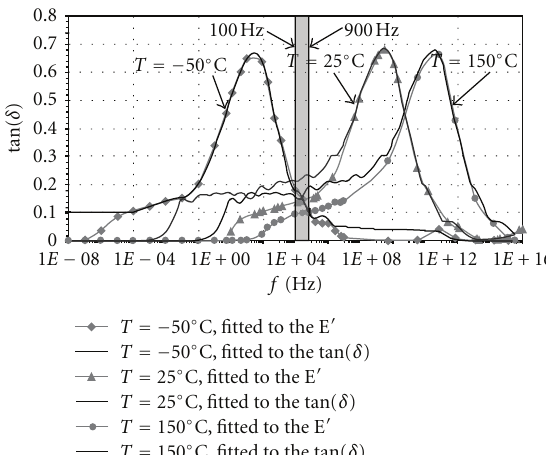
Figure 10: tan( δ ) versus frequency curves of EPDM v2 at three di ff erent temperatures in case of two di ff erent 40-term generalized